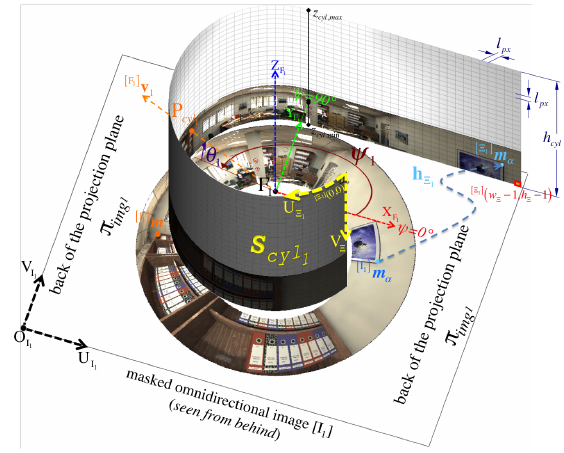
Figure 14. An example for the formation of panoramic image [ Ξ 1 ] out of the omnidirectional image [ I 1 ] (showing only the masked region of interest on the back of image plane π img ). Any particular ray, v 1 1 (cid:0) (cid:1) ψ 1 , θ 1 indicated by its elevation and azimuth such as [ F 1 ] that is directed towards the focus F 1 must traverse the projection cylinder S cyl at point P cyl . More abstractly, the figure also shows how a pixel 1 1 position [ Ξ 1 ] m α on the panoramic pixel space gets mapped from its corresponding pixel position [ I 1 ] m α via function h Ξ defined in Equation (85). Although not up to scale, it’s crucial to notice the relative 1 orientation between S cyl and the back of the projection plane π img where the omnidirectional image 1 1 [ I 1 ] is